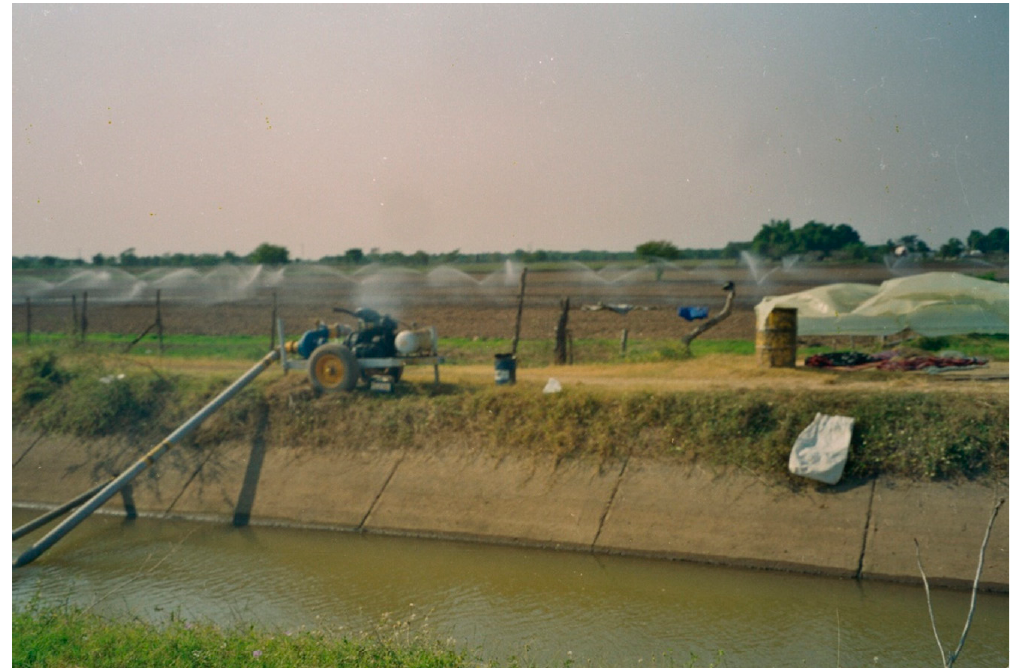
Figure 1. A sprinkler pump placed near an irrigation canal.